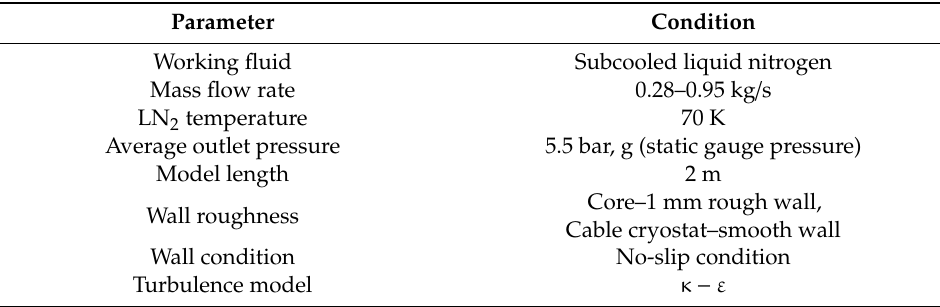
Table 6. CFD analysis boundary